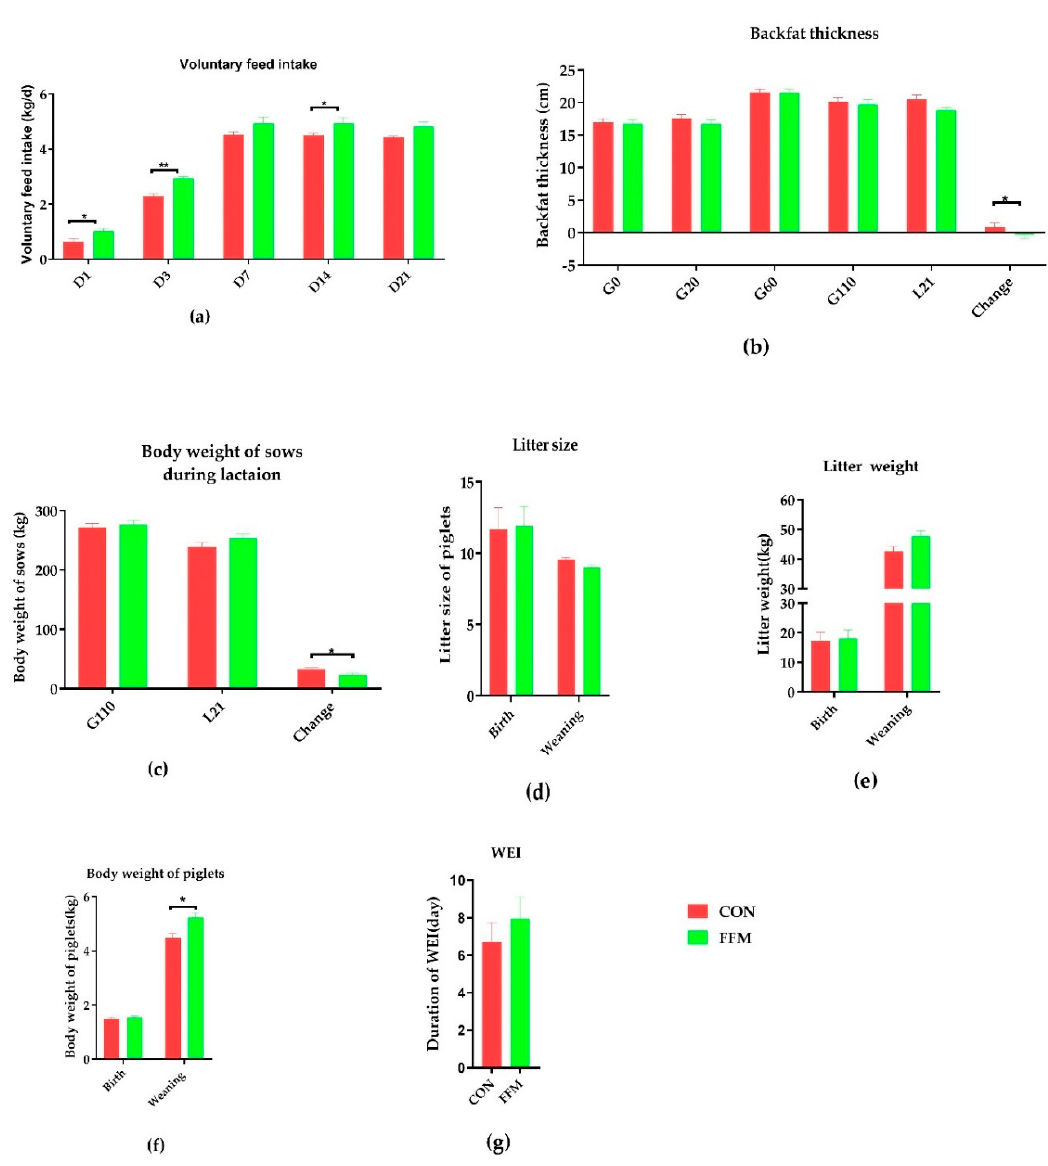
Figure 2. Effects of FFM supplementation on the reproductive performance of sows. ( a ) Daily voluntary feed intake during lactation, n = 10. ( b ) Backfat thicknesses on G0, G20, G60, G110, and L21 ( n = 20). ( c ) Bodyweights on G110 and L21 ( n = 10). ( d ) Litter sizes at birth and on Day 21 of weaning. ( e ) Litter weights at birth and on Day 21 of weaning. ( f ) Average piglet weights at birth and on Day 21 of weaning. The numbers of sows were as follows: CON ( n = 17) and FFM ( n = 20) at birth and CON ( n = 16) and FFM ( n = 15) at weaning. ( g ) Weaning and estrus intervals for CON ( n = 33) and FFM ( n = 34). CON represents the control diet. FFM represents the diet with 25.5% fermented feed mulberry. *represents p < 0.05, and ** represents p <